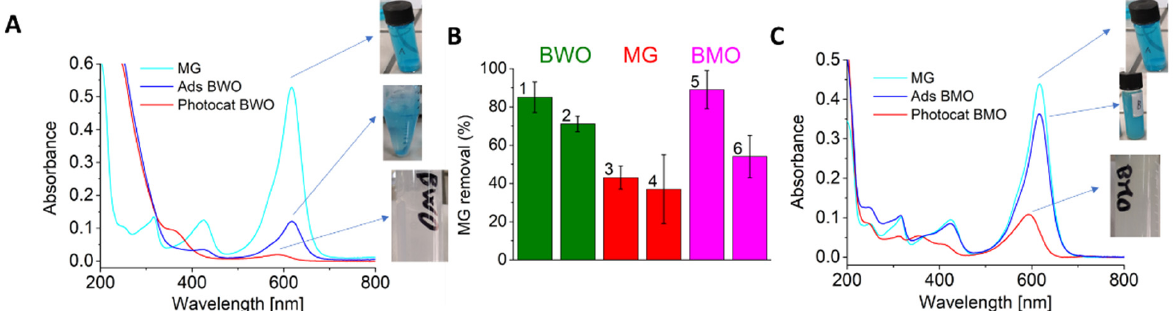
Figure 5. ( A ) Spectra of MG degradation by BWO. ( B ) MG removal with BWO, without photocatalyst and with BMO ( C ) Spectra of MG degradation by BMO.